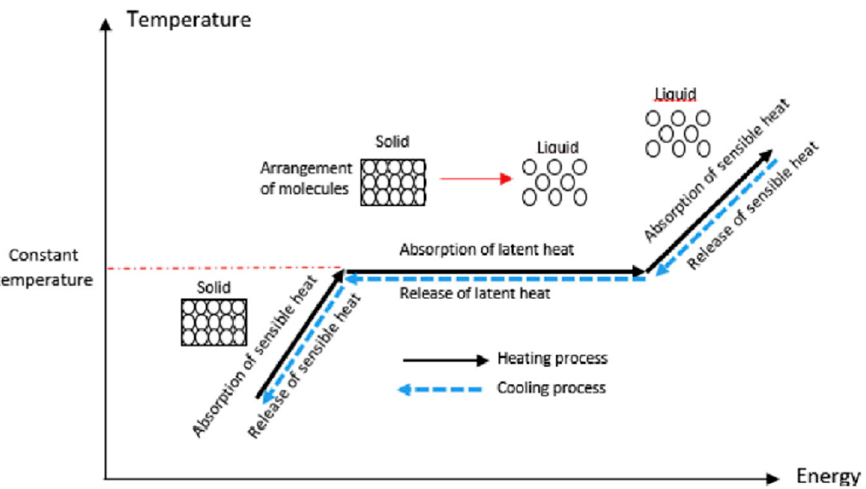
Figure 1. Temperature to energy absorption/release relation of a PCM. (Reprinted with permission from ref. [3]. Copyright 2019 Journal of Energy Storage).